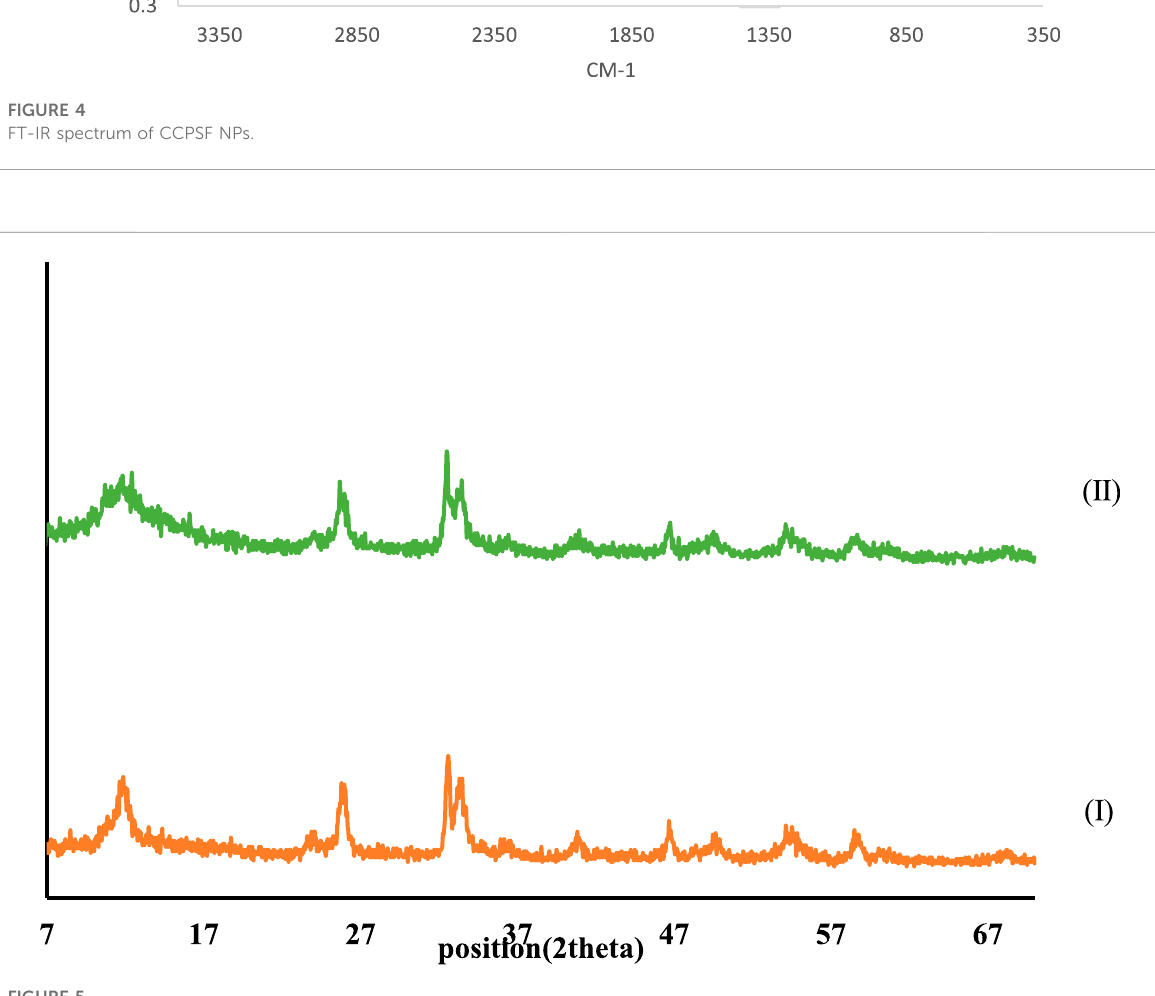
FIGURE 5 XRD patterns of synthesized cobalt composite (I) and CCPSF NPs